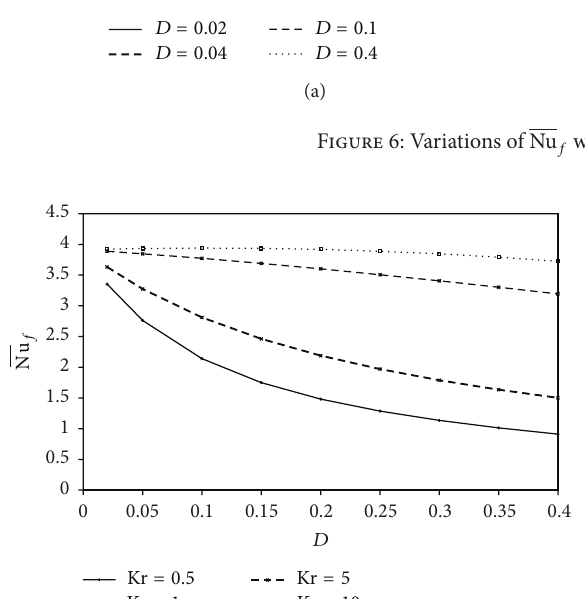
Figure 7: Variations of Nu 𝑓 with 𝐷 for different